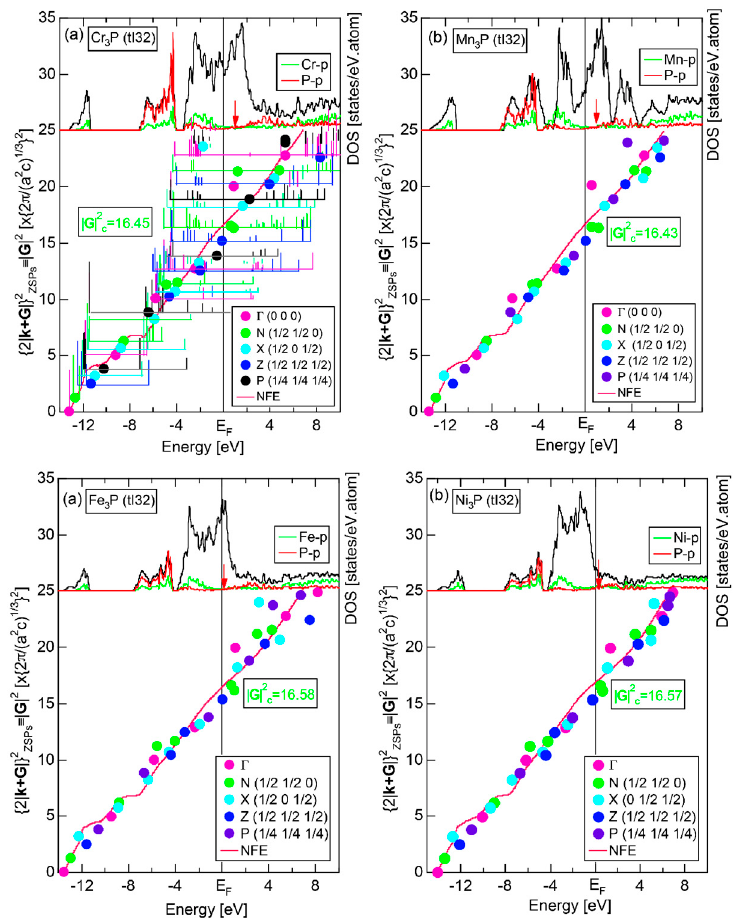
Figure 87. FLAPW − Fourier spectra at symmetry points Γ , N, X, Z, and P of the bct Brillouin zone for ( a ) Cr 3 P, ( b ) Mn 3 P, ( c ) Fe 3 P, and ( d ) Ni 3 P (tI32) [12]. A red arrow indicates the minimum in the partial DOSs. The energy dependence of the Fourier coefficients, ∑ | C max | 2 , is plotted only for Cr 3 P. The CG energy is plotted with different color circles.